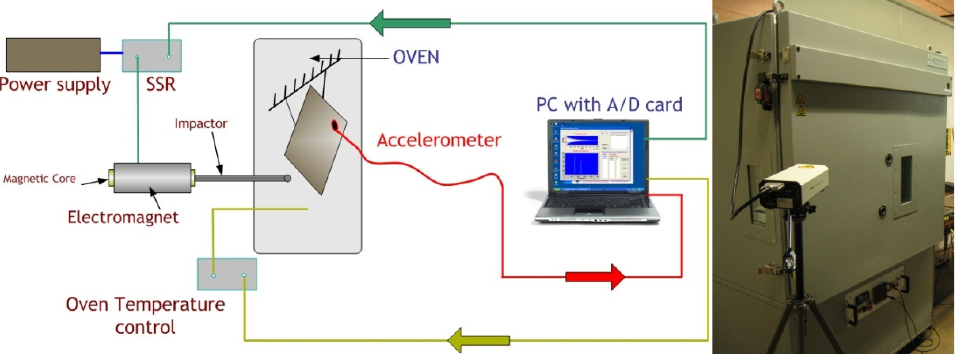
Fig. 4 . The measurement test setup